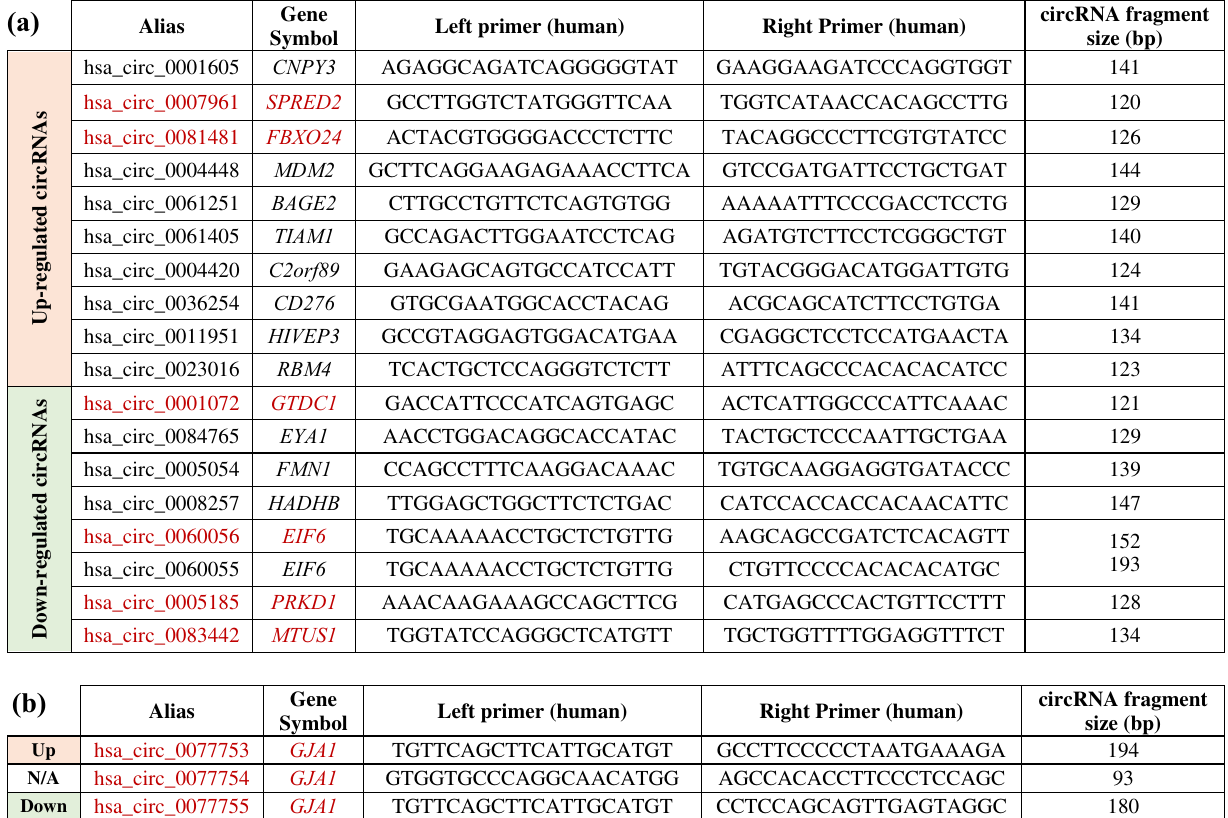
Table 1. Selection of 18 circRNAs involved in cancer-related and/or epithelial polarity pathways for RT-qPCR validation. (a) Ten up-regulated (of 75 significantly up-regulated) and eight down-regulated (of 46